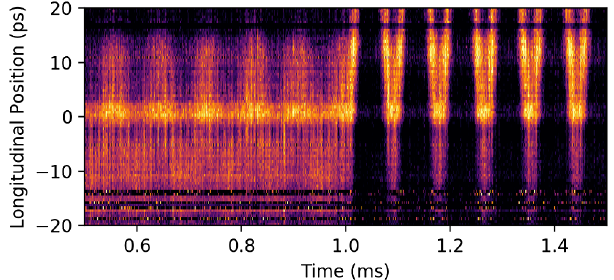
FIG. 5. Longitudinal bunch profiles recorded with the KALYPSO-based electro-optical spectral decoding setup. Each image column corresponds to one bunch profile. Synchrotron oscillations can be seen during the entire time range. The abrupt change of its amplitude at 1 ms is due to an rf phase step that leads to an oscillation around the new phase. The upper part of this oscillation is not visible due to the finite size of the line array and the length of the chirped laser pulse chosen to achieve a better temporal